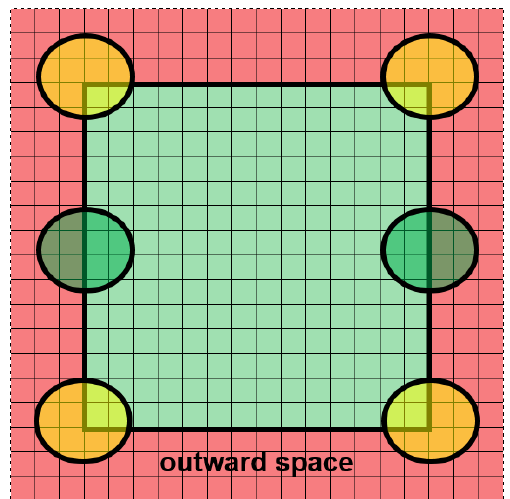
Figure 1. Periodic boundary conditions.